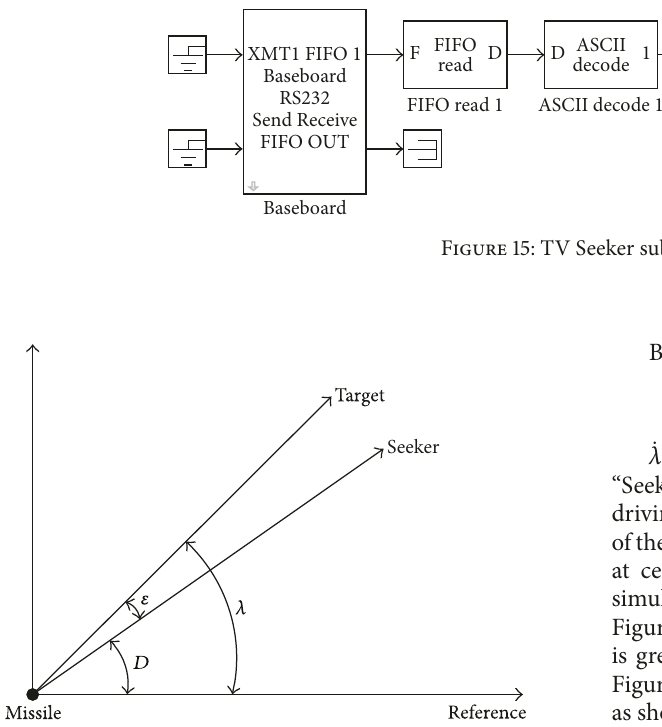
Figure 16: Basic geometry of the missile, seeker, and